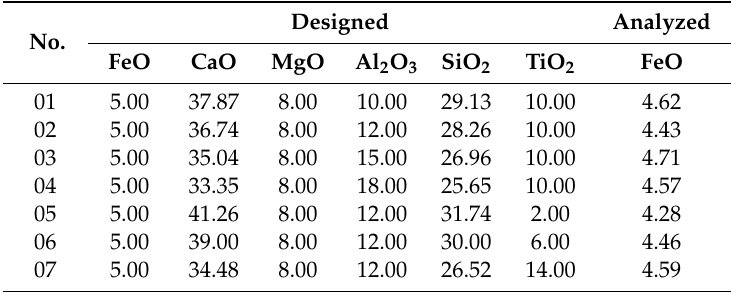
Table 1. Chemical compositions of designed Ti–bearing primary slags